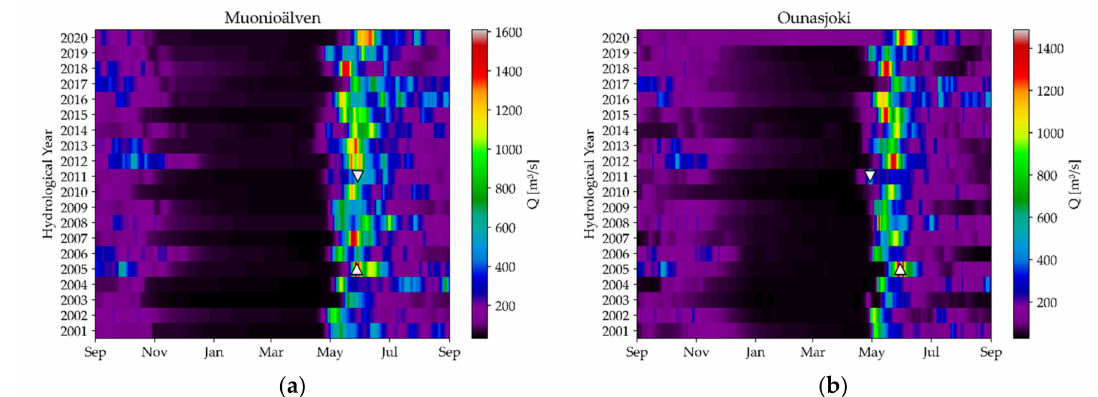
Figure 7. Discharge plots of ( a ) Muonioälven and ( b ) Ounasjoki. The upward pointing triangle indicates the maximum spring flood, the downward pointing the minimum.